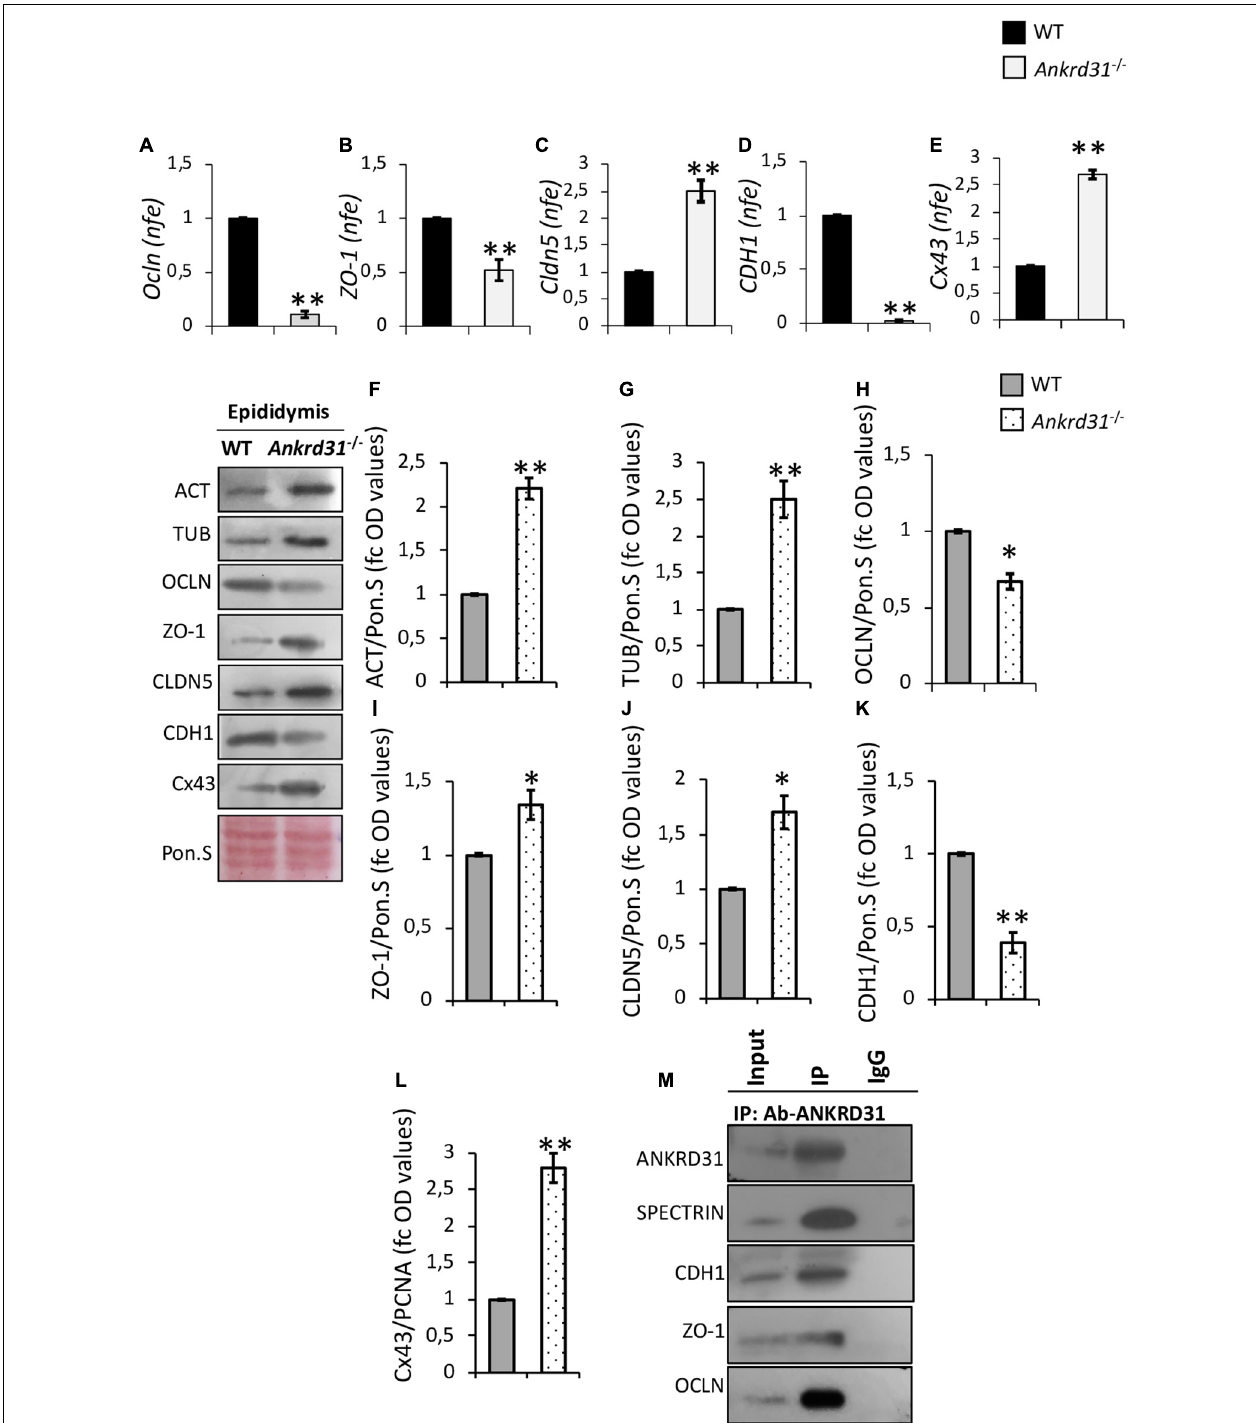
FIGURE 6 | Differential expression analysis of junction epithelial mRNAs between WT and Ankrd31 − / − epididymides by qRT-PCR. (A) Ocln , (B) ZO-1, (C) Cldn5, (D) CDH1, and (E) Cx43 expression levels were normalized using RP18S as a housekeeping gene and expressed as normalized fold expression (n.f.e.). All data are reported as mean value ± S.E.M; ** p < 0.01. Western blot analysis of (F) actin, (G) tubulin, (H) OCLN, (I) ZO-1, (J) CLDN5, (K) CDH1, and (L) Cx43 proteins levels in WT and Ankrd31 − / − epididymides. Signals were quantified by densitometry analysis and normalized to Ponceau Red (Pon.S). Data are expressed in OD values as fold change and reported as mean ± SEM, * p < 0.05; ** p < 0.01. (M) IP in WT epididymides. Total proteins collected from WT epididymides were immunoprecipitated using ANKRD31 antibody. Protein interaction among ANKRD31, SPECTRIN, CDH1, ZO-1, and OCLN was detected by Western blot analysis.